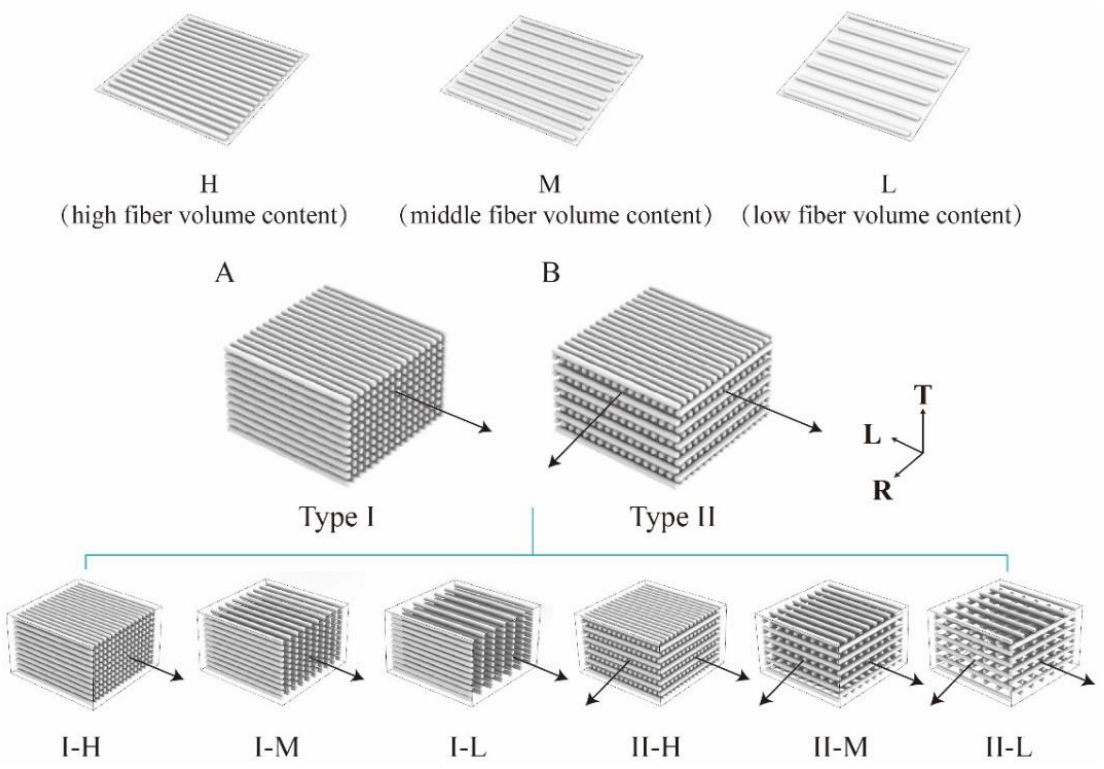
Figure 1. Experimental laminated structure: ( A ) type I: parallel lamination with varying fiber volume; ( B ) type II: cross lamination with varying fiber volume. Arrows indicate the direction of grain in the veneer layers; T, thickness; L, length; and R, width. I-H, parallel lamination with high fiber volume content composites; I-M, parallel lamination with middle fiber volume content composites; I-I, parallel lamination with low fiber volume content composites; II-H, cross lamination with